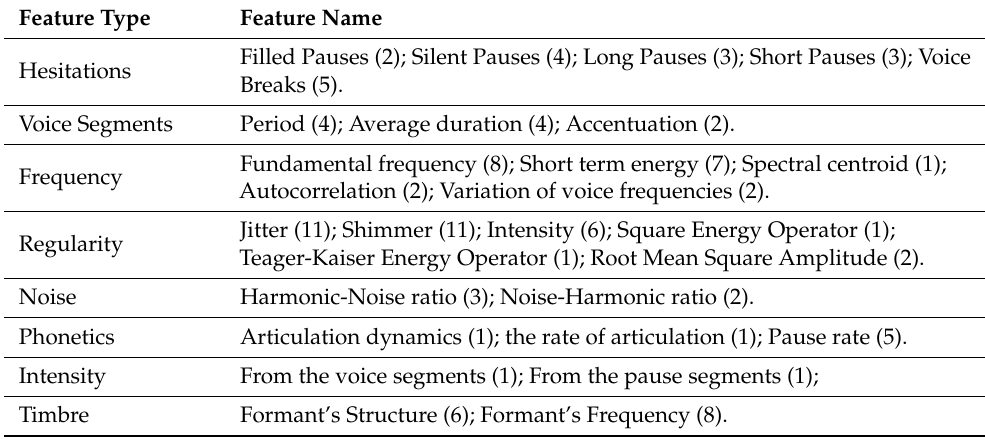
Table 4. Acoustic features that have been used for AD detection. The features are organized by type. For each feature name, the number of occurrences/usages is provided inside